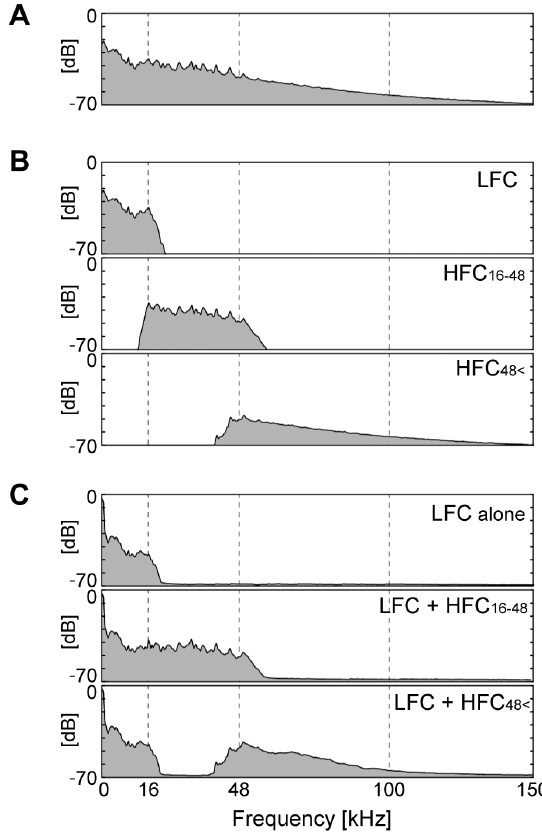
Figure 2. Averaged power spectra of sound materials applied in Experiment 1. A: Electric signal of the sound source. B: Filtered electric signals of LFC under 16 kHz (control), HFC at 16–48 kHz, and HFC at 48 kHz , . C: The sounds and air vibration reproduced by the frequency-variable sound application system. Power was calculated from the data recorded at the subject’s position. Faithful reproductions from electric signals to air vibrations were observed.